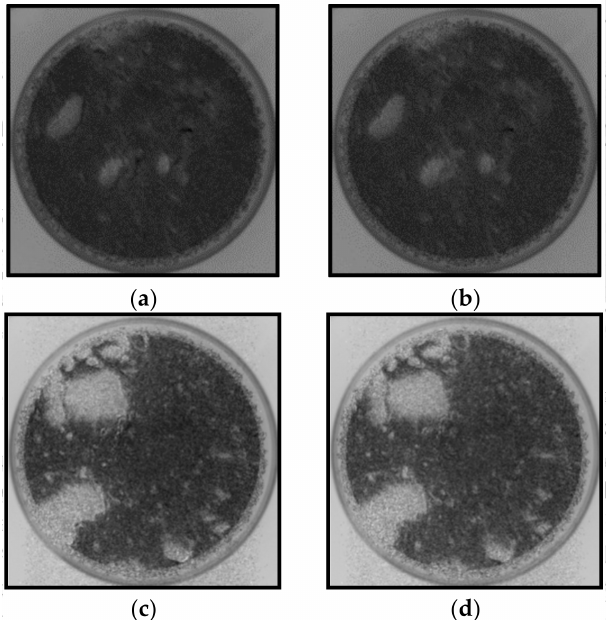
Figure 4. Single energy PEEM images showing the distribution of surface iron speciation on pyrite exposed to HH medium. The iron rich regions are light and iron deficient regions are dark. After 2 h of exposure ( a ) unaltered pyrite, 707.6 eV; ( b ) iron oxyhydroxides, 708.5 eV; and after 168 h ( c ) indicates unaltered pyrite and ( d ) iron